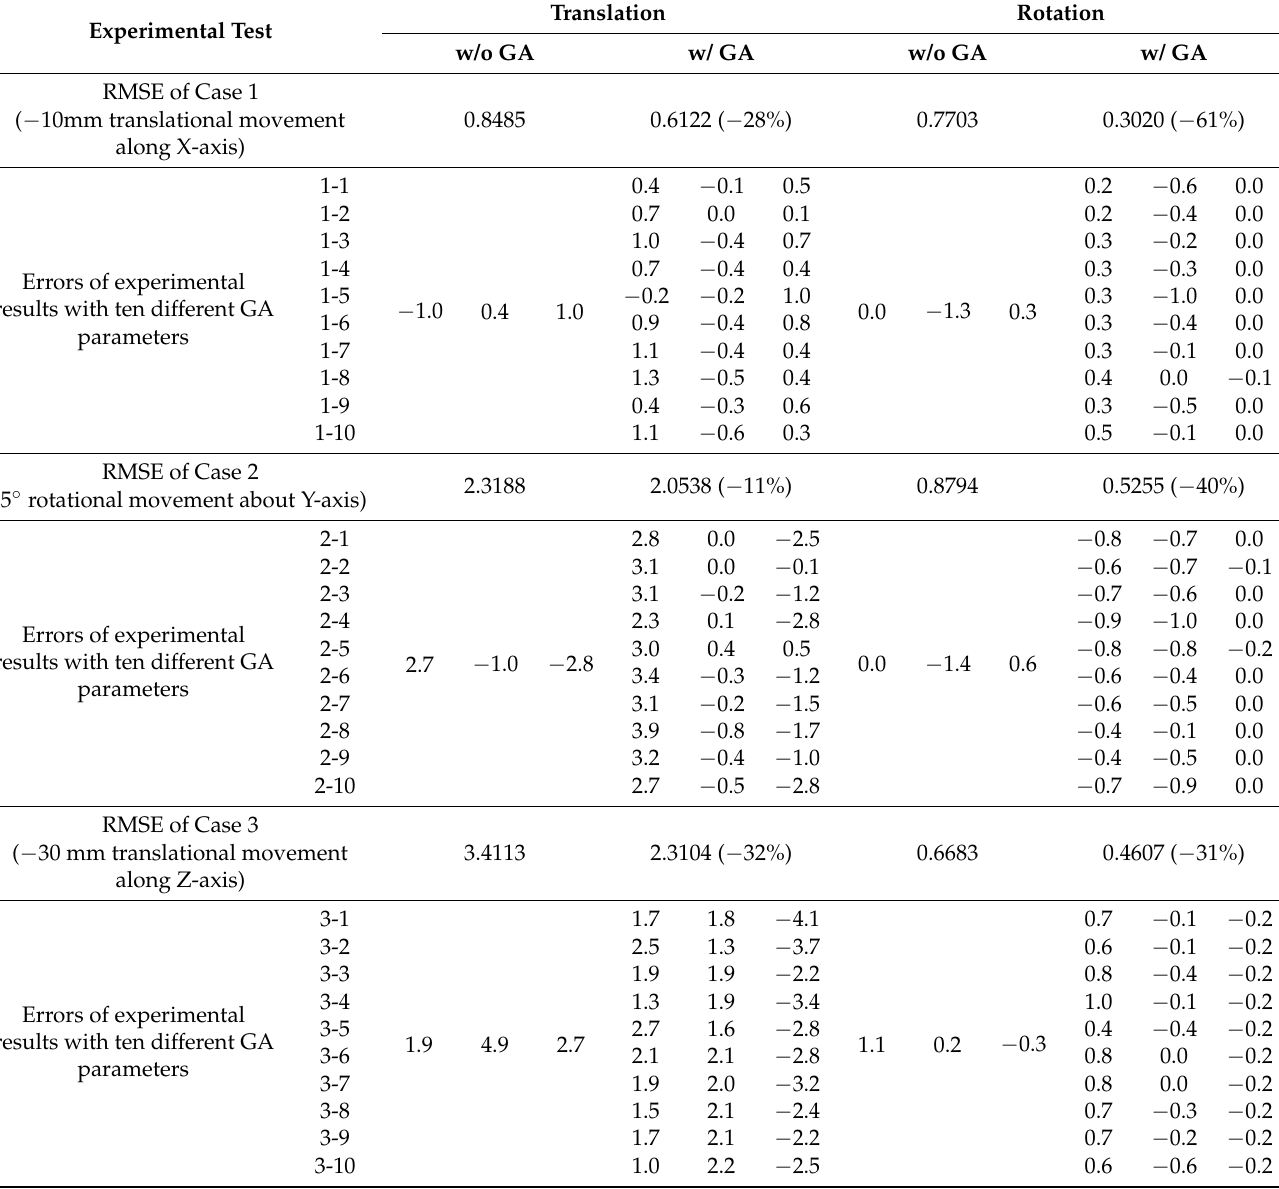
Table 2. Root mean square error (RMSE) of 6-DOF displacement